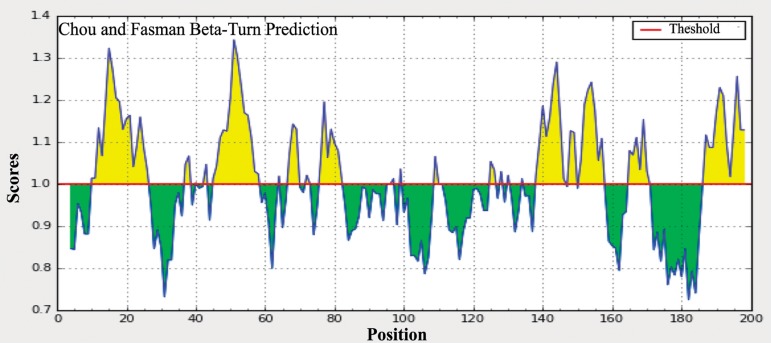
Chou and Fasman β-turns prediction of Arabian camel HSPB-1 protein.The threshold is 1.00. The regions having β-turns in the protein are shown in yellow color.